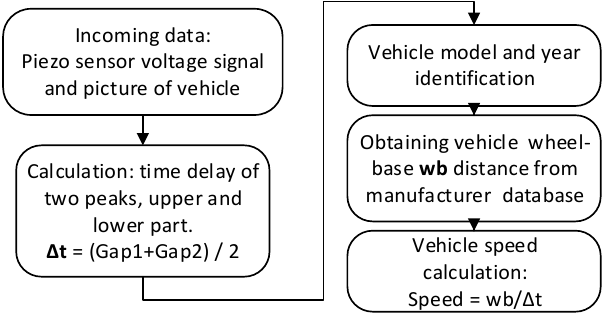
Figure 3. Functional diagram of the reference system.